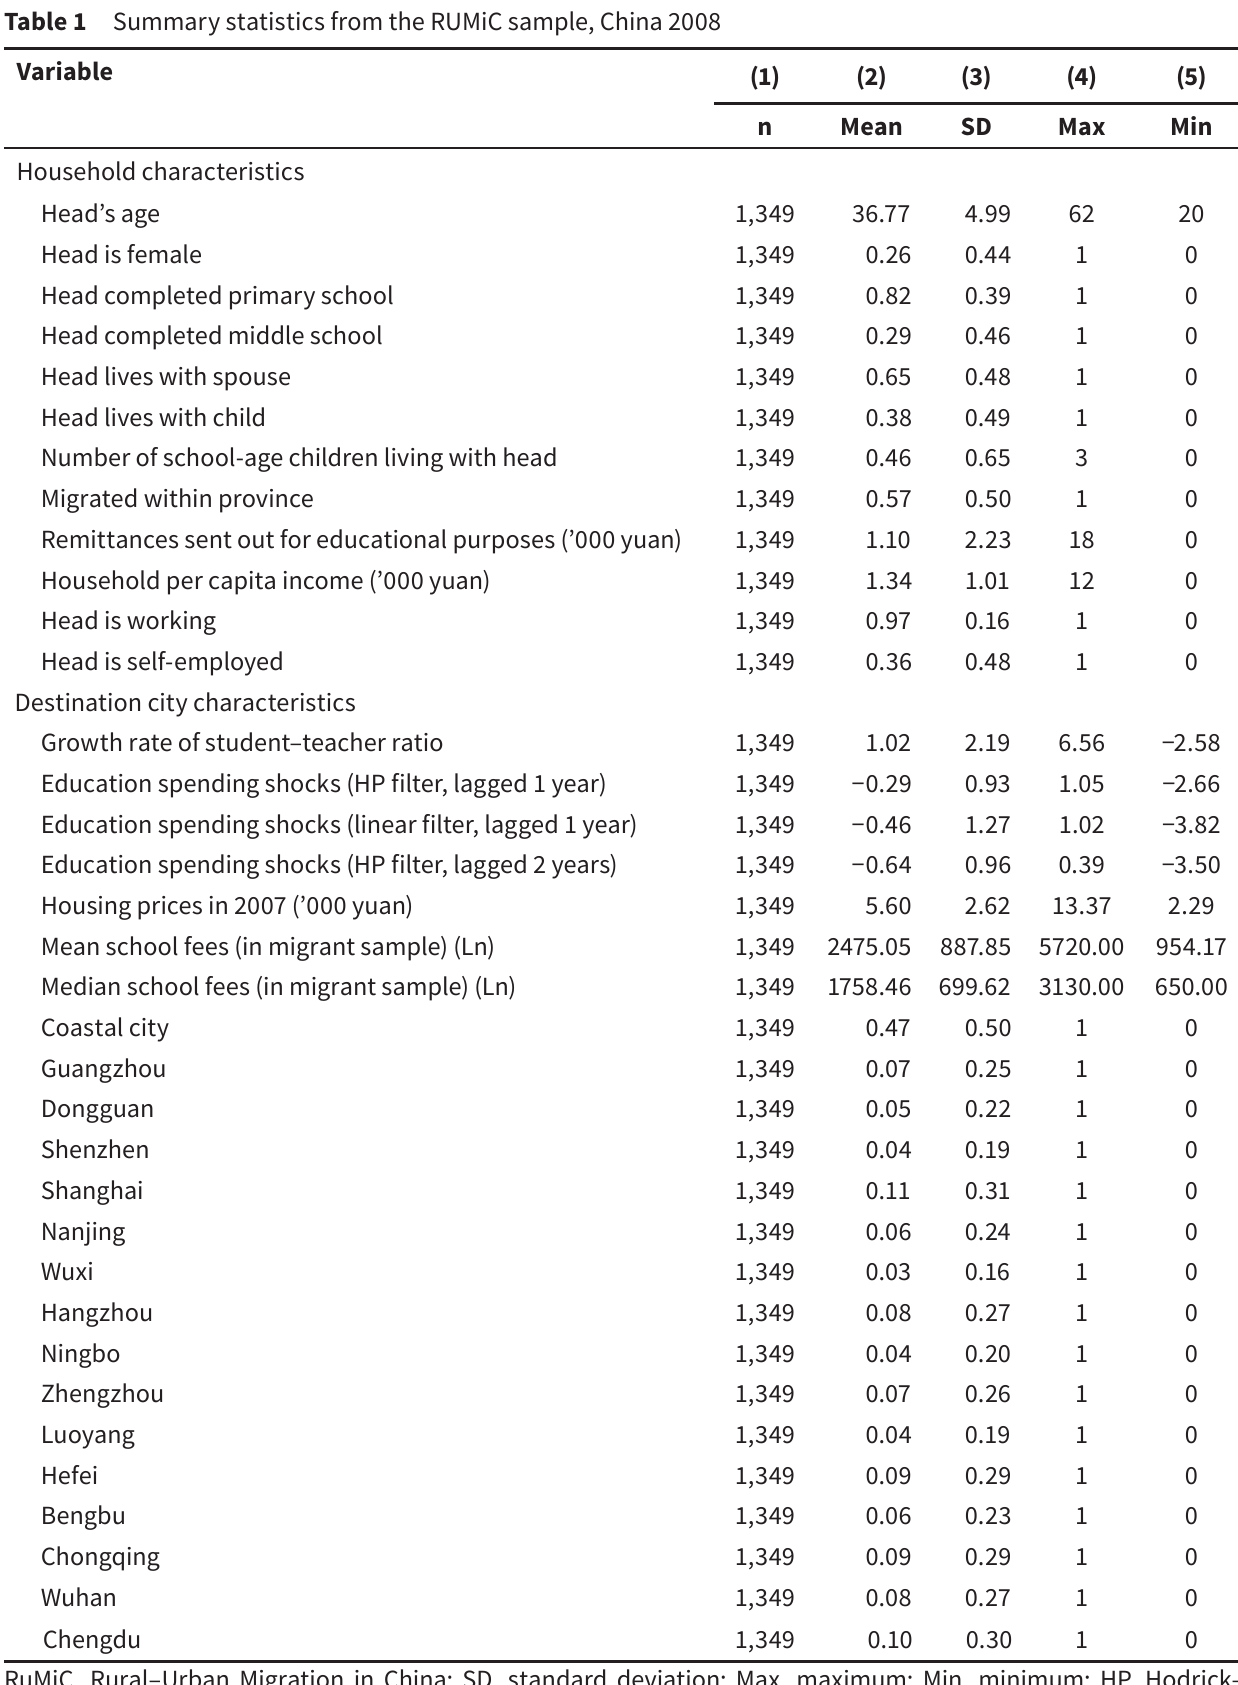
Summary statistics from the RUMiC sample, China